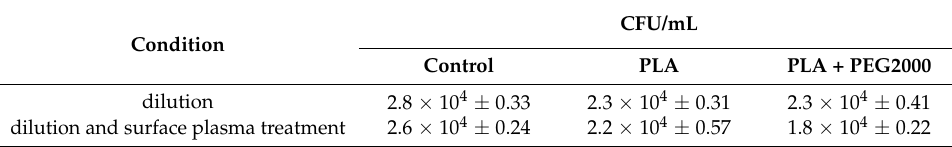
Table 1. Colonies on control, poly(lactic acid) fabric, and PEG2000-coated poly(lactic acid)